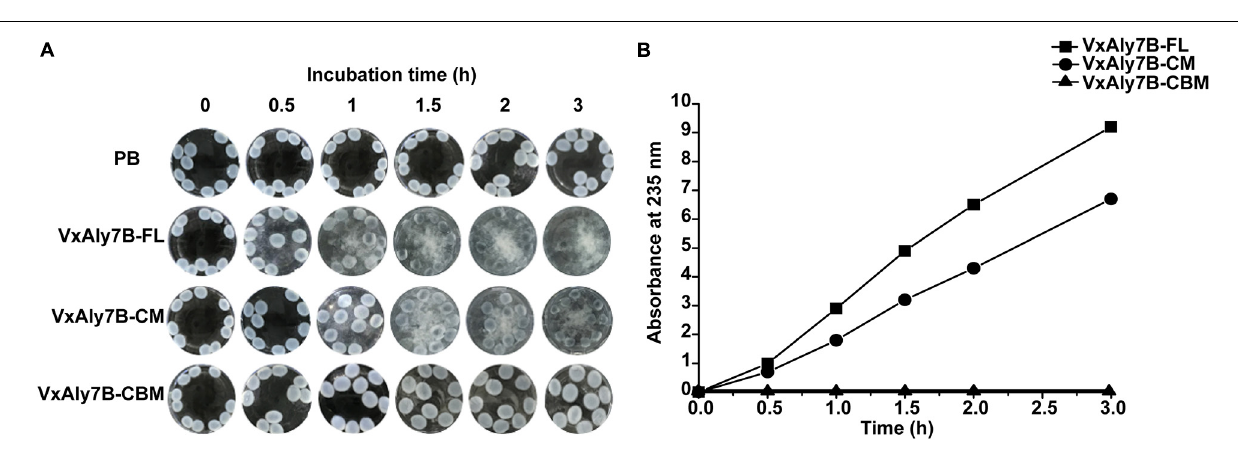
FIGURE 5 | Degradation ability of CBM32 on alginate gel beads. (A) Catalytic effect of recombinant VxAly7B-FL, VxAly7B-CM, and VxAly7B-CBM on alginate gel beads. (B) Changes in the reducing sugar contents of recombinant VxAly7B- FL-, VxAly7B-CM- and VxAly7B-CBM-degraded alginate gel beads (VxAly7B-FL, square; VxAly7B-CM, circle; VxAly7B-CBM,